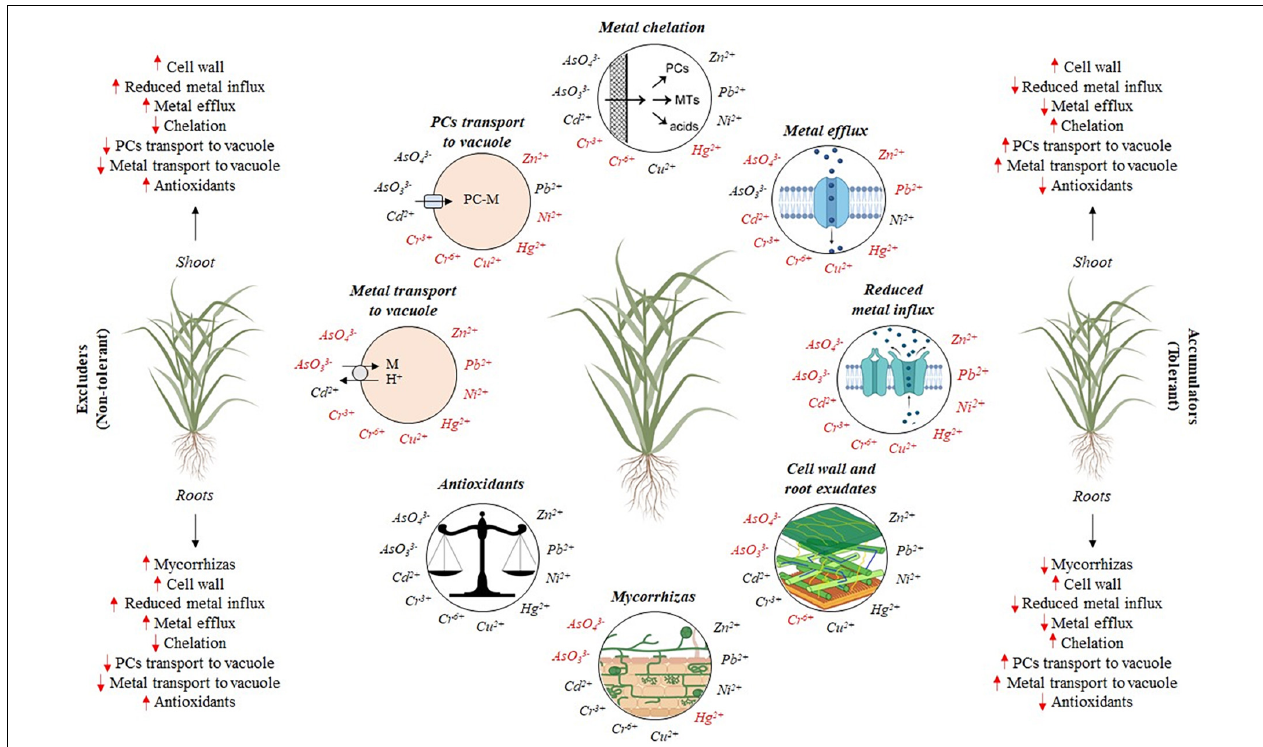
FIGURE 4 | Summary of cellular mechanisms involved in metal detoxification and tolerance in grasses: (i) restriction of metal movement to roots by mycorrhizas; (ii) binding to the cell wall and root exudates; (iii) reduced influx across plasma membrane; (iv) active efflux into the apoplast; (v) chelation in the cytosol by phytochelatins (PCs), metallothioneins (MTs), amino acids and organic acids; (vi) transport of PC-M complex into the vacuoles; (vii) transport and accumulation of metal (M) not chelated into the vacuole; (viii) the balance between antioxidants and oxidants. Adapted from Hall (2002). Red arrows indicate which tolerance mechanisms are possibly more ( ↑ ) or less ( ↓ ) requested by excluder and accumulator grasses. Metals written in red indicate the need for further studies in relation to each specific tolerance mechanism or indicate that the tolerance mechanism is not employed in its